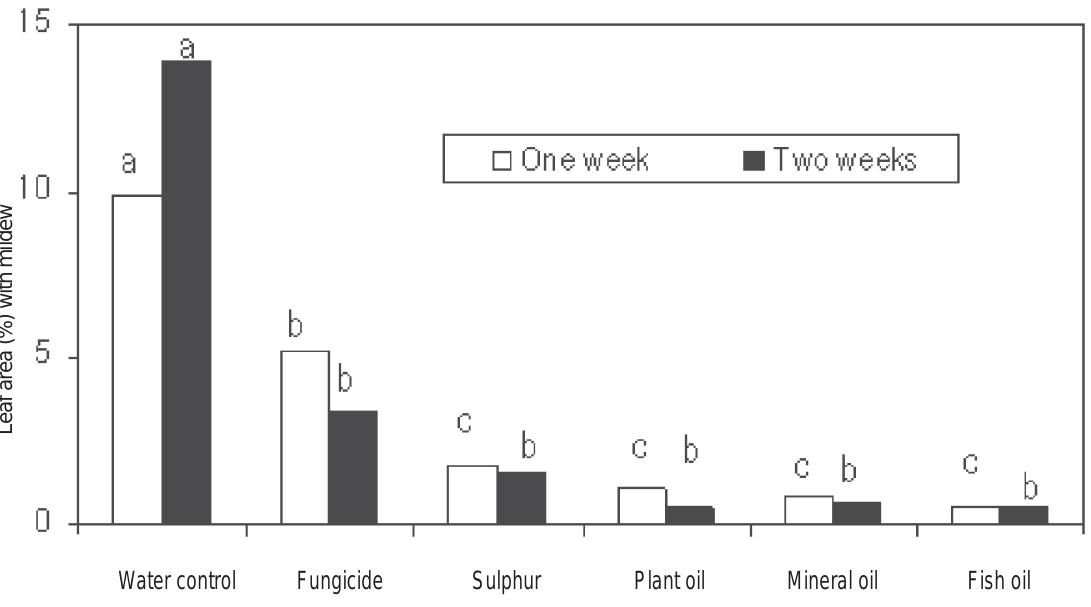
Fig. 1. Mean percentage of affected leaves one or two weeks after spraying oils at 1%, fungicide (Tebuconazole) at 0.05% or colloidal sulphur at 3 g l -1 . Means with the same letter do not differ significantly at the 5% level (Tukey HSD tests).